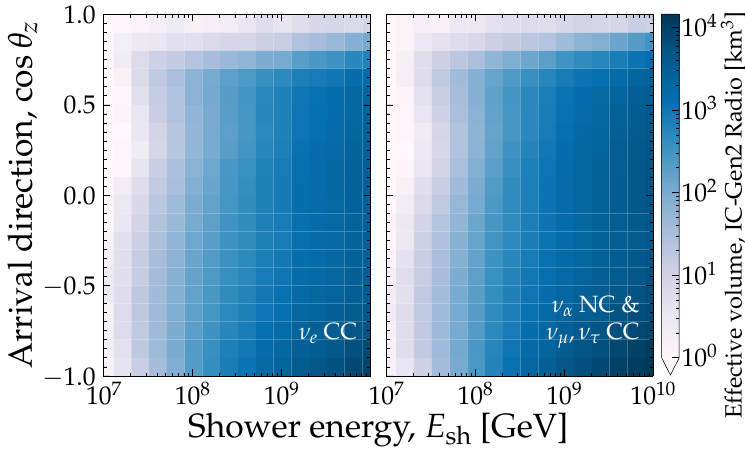
Figure 13 . Effective volume of the baseline design of the full IceCube-Gen2 radio array. This is the sum of the effective volumes of 144 hybrid (shallow + deep) stations plus 169 shallow-only stations. . Right: volume for NC interactions of all flavors and CC Left: volume for ν e CC interactions, V CC eff ,ν e interactions of ν and ν , V NC . See figure 12 for the effective volumes of single stations and the µ τ eff ,ν α main text for